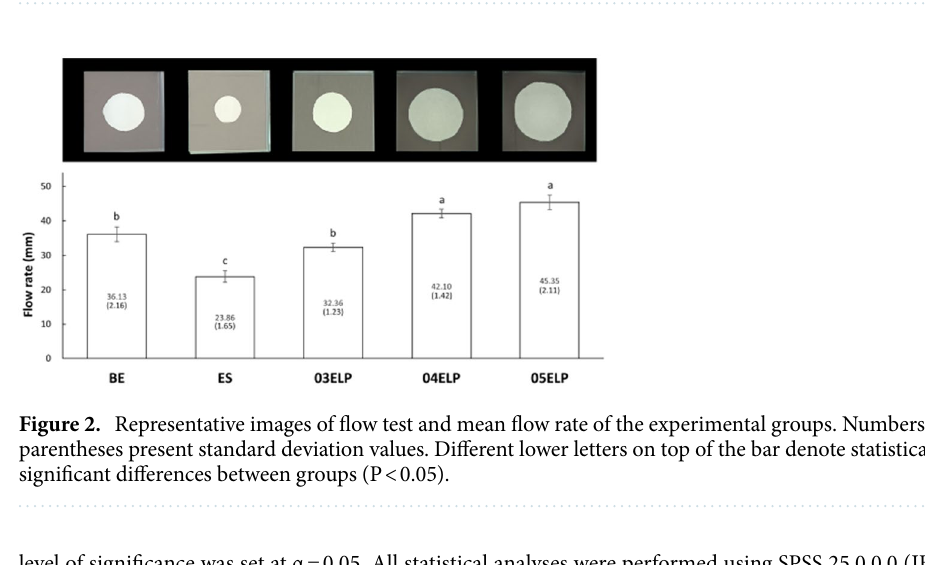
Figure 1. Push-out bond strength of the experimental groups. Different lower letters on top of the bar denote statistically significant differences between groups (P < 0.05).